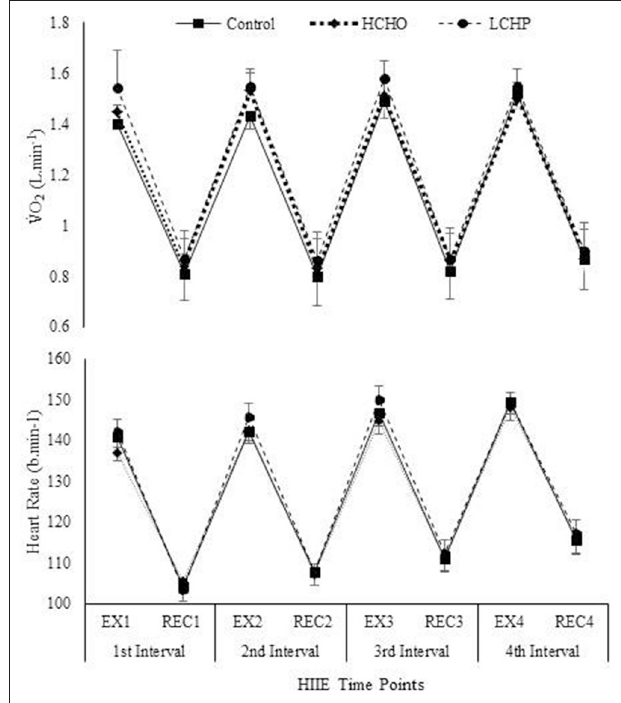
FIGURE 2 | VO 2 consumption and Heart Rate during HIIE protocol in control, HCHO and LCHP conditions. Values are means ± SEM, n = 12. EX1, 4-min exercise in the 1st Interval; REC1, 3-min active recovery in the 1st interval; EX2, 4-min exercise in the 2nd Interval; REC2, 3-min active recovery in the 2nd interval; EX3, 4-min exercise in the 3rd Interval; REC3, 3-min active recovery in the 3rd interval; EX4, 4-min exercise in the 4th Interval; REC4, 3-min active recovery in the 4th